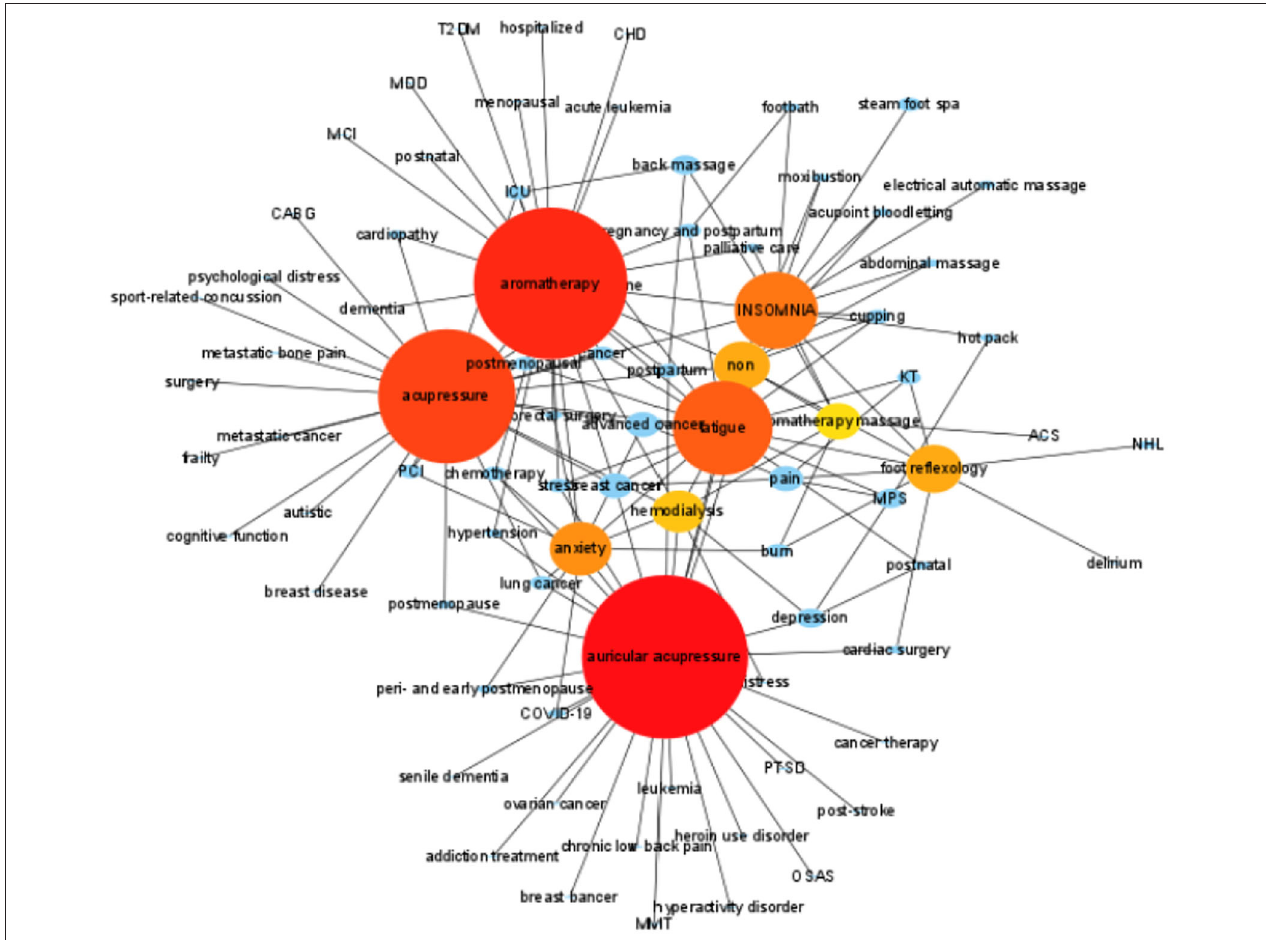
FIGURE 8 | Clustering graph based on article